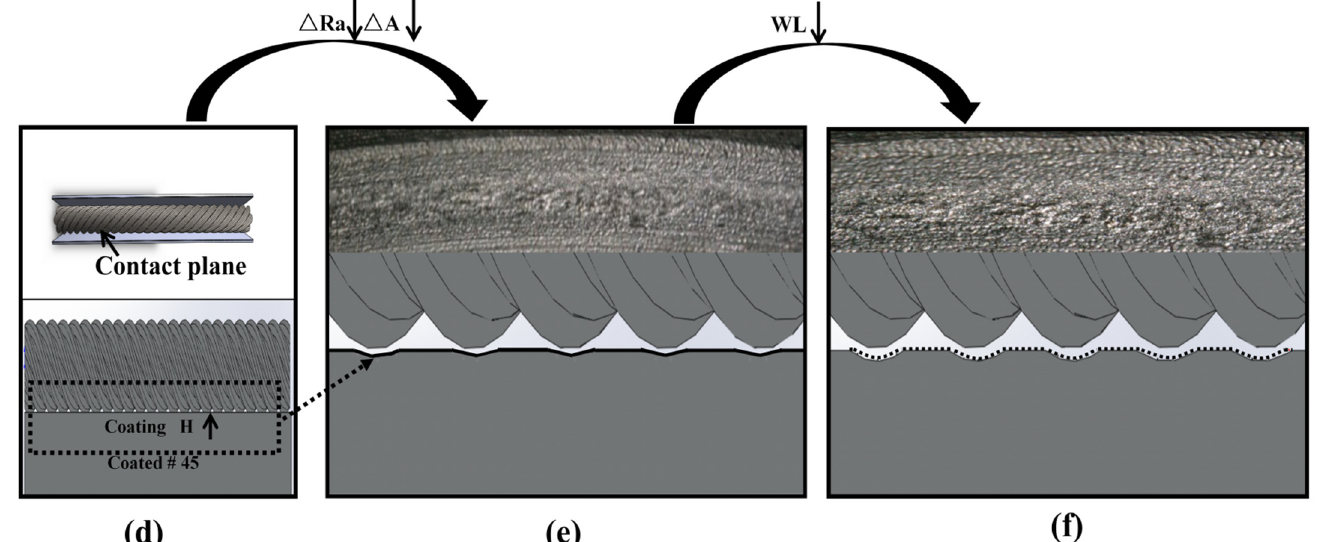
Figure 13. Wear mechanism analysis of traction wheel. ( a ) Substrate rope–wheel model. ( b ) Early wear stage of rope–wheel model. ( c ) Late wear stage of rope–wheel model. ( d ) Chromed rope– wheel model. ( e ) Early wear stage of chromed rope–wheel model. ( f ) Late wear stage of chromed rope–wheel model.